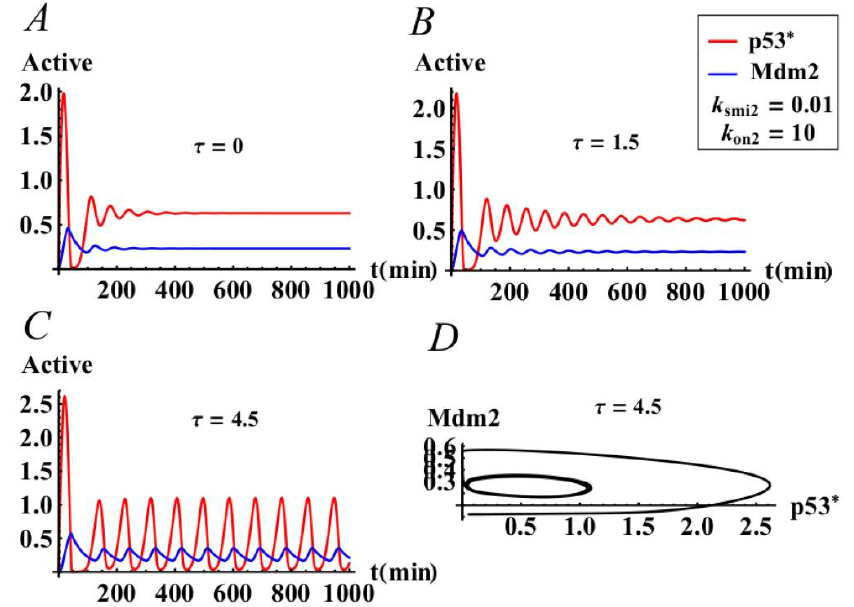
Figure 6. The e ff ects of time delay τ on the p53-Mdm2 system of model (1) when there is certain expression of miR34-a. ( A ) The positive equilibrium is asymptotically stable when τ = 0. ( B ) The positive equilibrium is asymptotically stable when τ = 1.5 < τ 0 = 3.5578. ( C , D ) The positive equilibrium is unstable when τ = 4.5 > τ 0 = 3.5578.